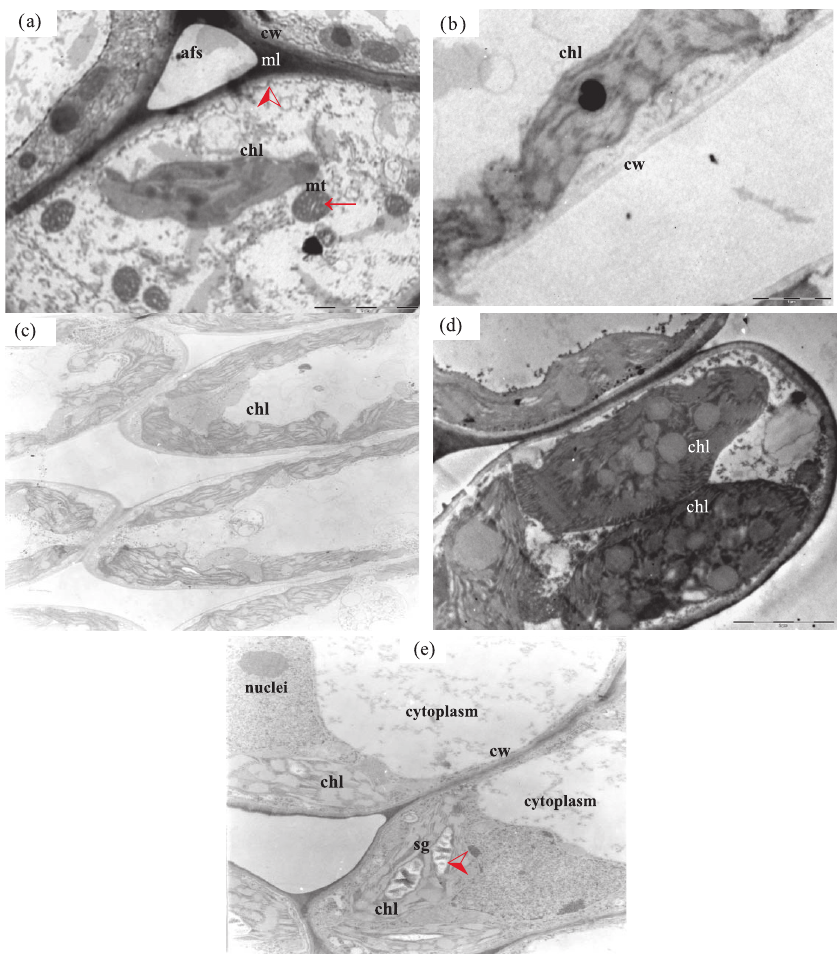
figure 1. transmission electron microscopy images of cells of the leaf mesophyll of the castor bean hybrid “iris”: (a) plant cells (x 3,000) grown in a nutrient solution without boron, showing chloroplasts (chl) with reduced and stacked thylakoids (grana), mitochondria (mt), thickened middle lamellae (ml) and cell wall (cw), apparent free space (afs); (b) plant cells (x 4,400) grown in a nutrient solution without copper; (c) plant cells (x 3,000) grown in a nutrient solution without manganese; (d) plant cells (x 3,000) grown in a nutrient solution without zinc; and (e) plant cells (x 3,000) grown in a complete nutrient solution, showing starch grains (sg), well organized nuclei and chloroplasts (chl) well distributed in the cytoplasm. cells with well-defined walls and middle lamellae. the scale of the electromicrographs is 2 µm (except figure 1(c) and (e), in which it is 1